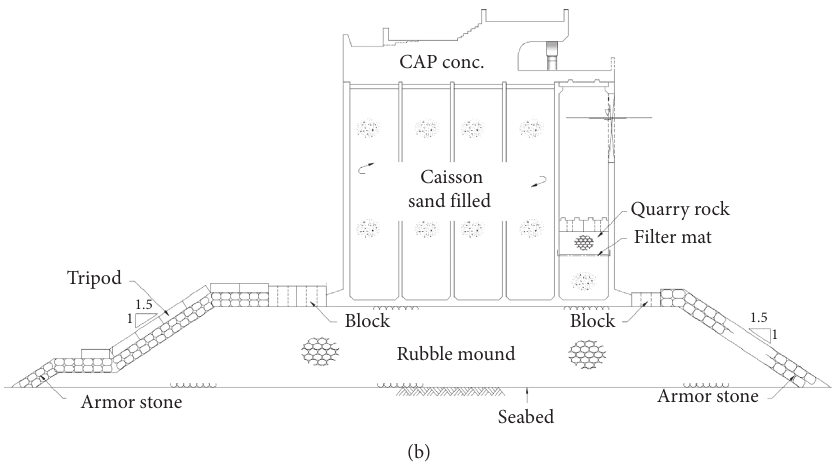
Figure 10: Schematic diagram of (a) layout of caissons in the west breakwater and (b) a composite nonperforated caisson.